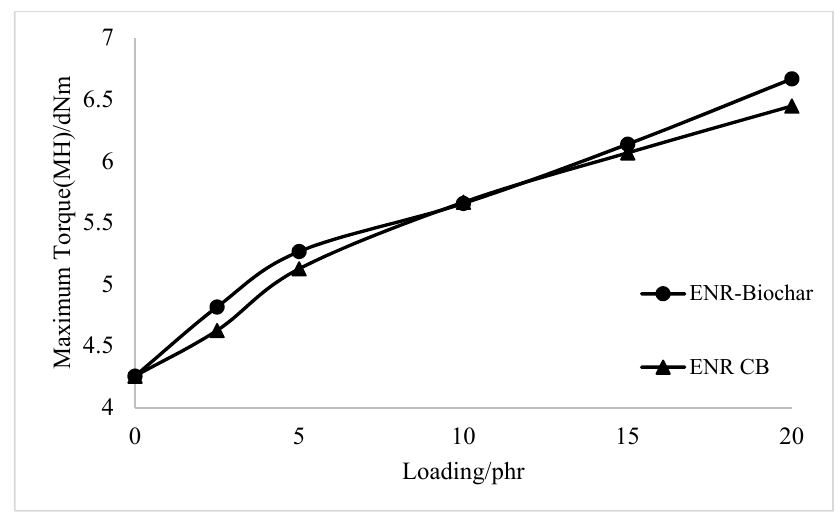
Figure 2. Cure time (tc90) of the ENR, ENR ‐ Biochar and ENR ‐ CB.